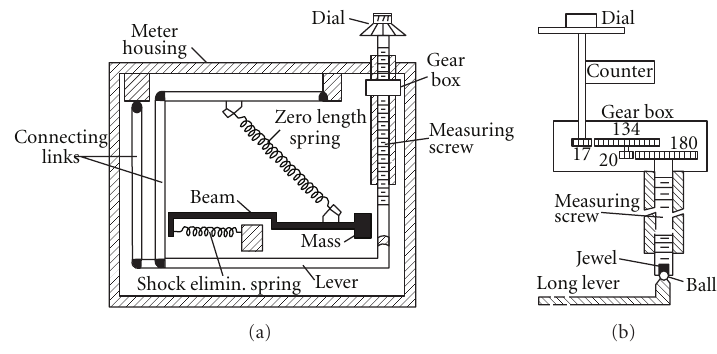
Figure 3: Schematic of a La Coste-Romberg gravity meter.